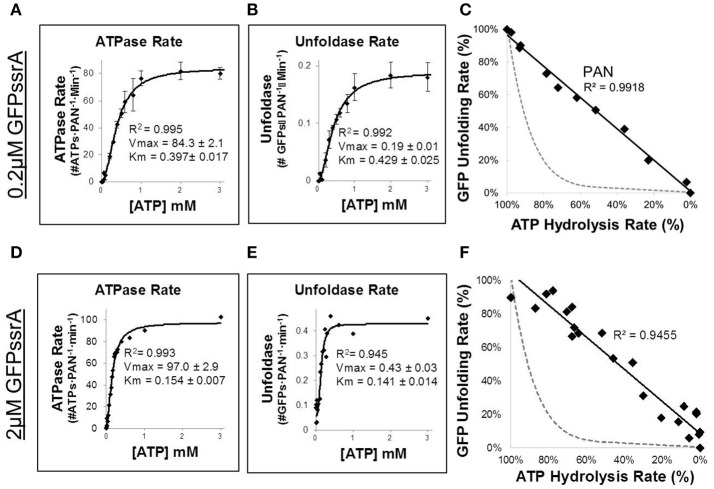
PAN does not stall when it encounters the unfolded domain of GFP. (A,B) To determine mechanochemical coupling efficiency at ~Km levels of GFPssrA, ATP hydrolysis and GFPssrA unfolding (2 μM) were assessed concurrently, in the same well, using an NADH-coupled ATPase assay combined with GFPssrA unfolding (see Materials and Methods Section). Rate of ATP hydrolysis was measured by loss of NADH absorbance at 340 nm (A), while at the same time GFPssrA unfolding rate was measured by loss of fluorescence at ex/em: 485/510 (B). (C) Efficiency of mechanochemical coupling of ATP hydrolysis to GFPssrA was determined by plotting relative percentage ATPase and unfoldase onto a 2 dimensional plot and fitting with a line (R2 = 0.9918). The dotted gray line is a hypothetical example of an ATPase that stalls (e.g., ClpX), where stalling is defined as <5% of the maximal degradation rate when the ATPase rate is 50% of maximal (Nager et al., 2011). (D–F) Same as (A–C), but at saturating GFPssrA substrate concentration (2 μM). Error bars are standard deviations from three independent experiments (n = 3).